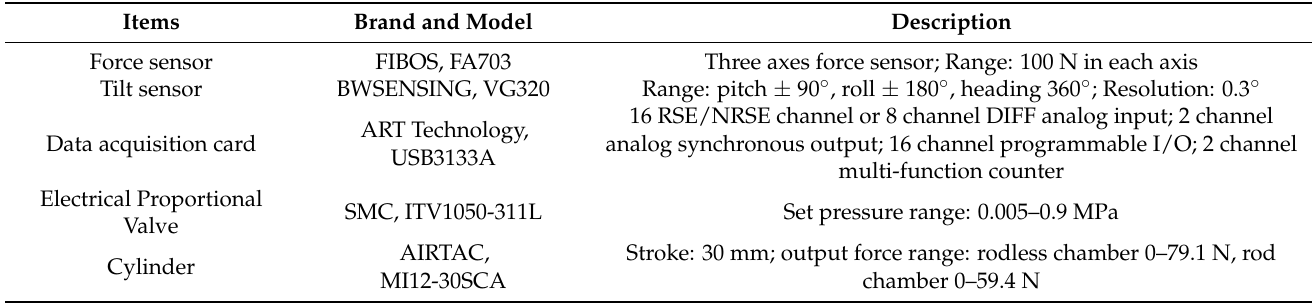
Table 1. Model and description of devices used in force-controlled actuators.